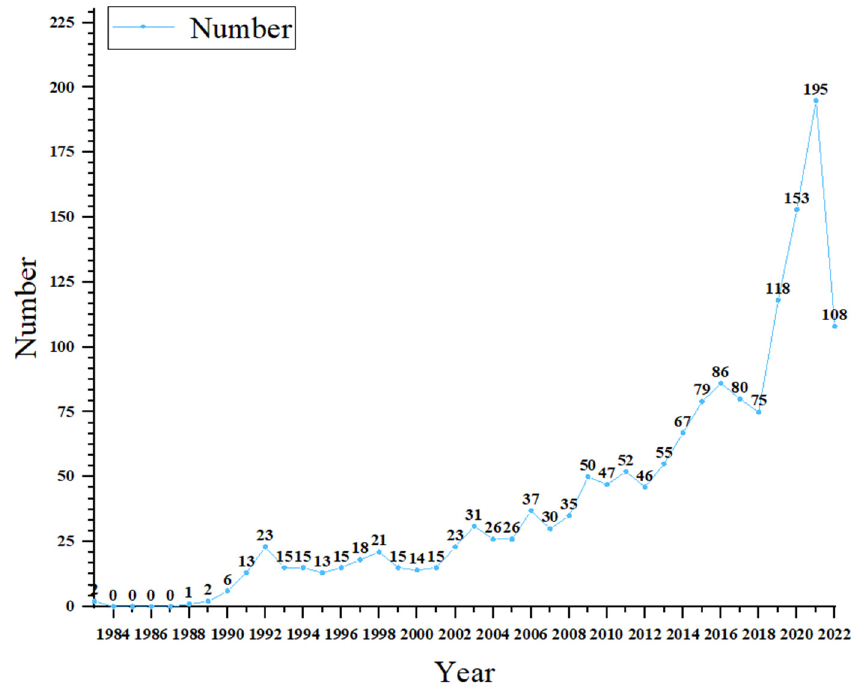
Figure 1. Number of publications contributed on BSC topics per year from 1983–2022.